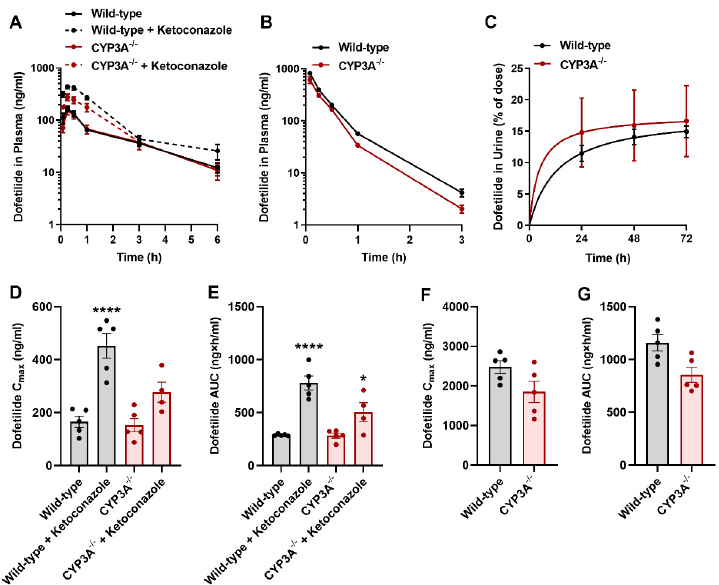
Figure 5. CYP3A inhibition does not influence the pharmacokinetics of dofetilide. ( A ) Plasma concentration-time profile of dofetilide (5 mg/kg, p.o.) in male wild-type or CYP3A-deficient mice pretreated with ketoconazole (100 mg/kg) 30 min before dofetilide (n = 5 per group). ( B ) Plasma concentration-time curves profile of dofetilide receiving an i.v. dose of 2.5 mg/kg in male wild-type or CYP3A-deficient mice (n = 5). ( C ) Urinary excretion of dofetilide in male wild-type and CYP3A-deficient mice (n = 5) following a single dose of dofetilide (2.5 mg/kg, i.v.). Pharmacokinetic parameters of dofetilide in male wild-type and CYP3A-deficient mice receiving an oral (5 mg/kg) ( D , E ), and i.v. (2.5 mg/kg) dose ( F , G ). Statistical analysis was performed using one-way ANOVA with Dunnett’s post hoc test: * p < 0.05, **** p < 0.0001 compared with wild-type mice receiving vehicle alone. All data represent the mean ± SEM.